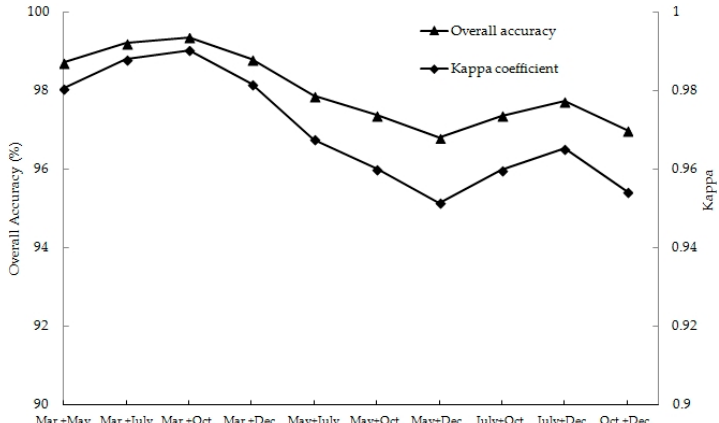
Figure 6. Overall classification accuracies and Kappa coefficient values for land cover classification from the ten combined two-season images using the ten predictive variable selection datasets listed in Table 5. Table 6. Confusion matrix showing the producer’s and user’s classification accuracies for three land cover classes obtained from the selected predictive variable datasets of the combined March– October images.